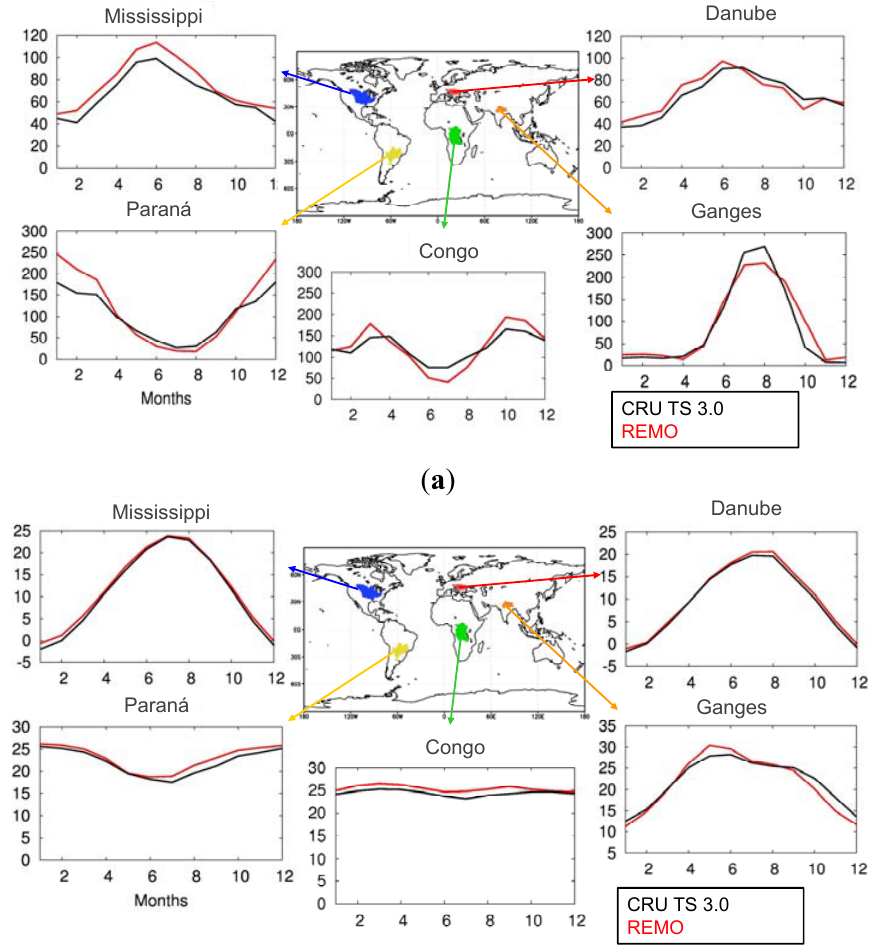
Figure 4. Annual cycles of ( a ) Precipitation [mm/month] ( b ) Temperature [°C] of selected catchments over each domain. Black and Red curves denote the CRU observations and REMO results respectively. The period considered is 1989 to